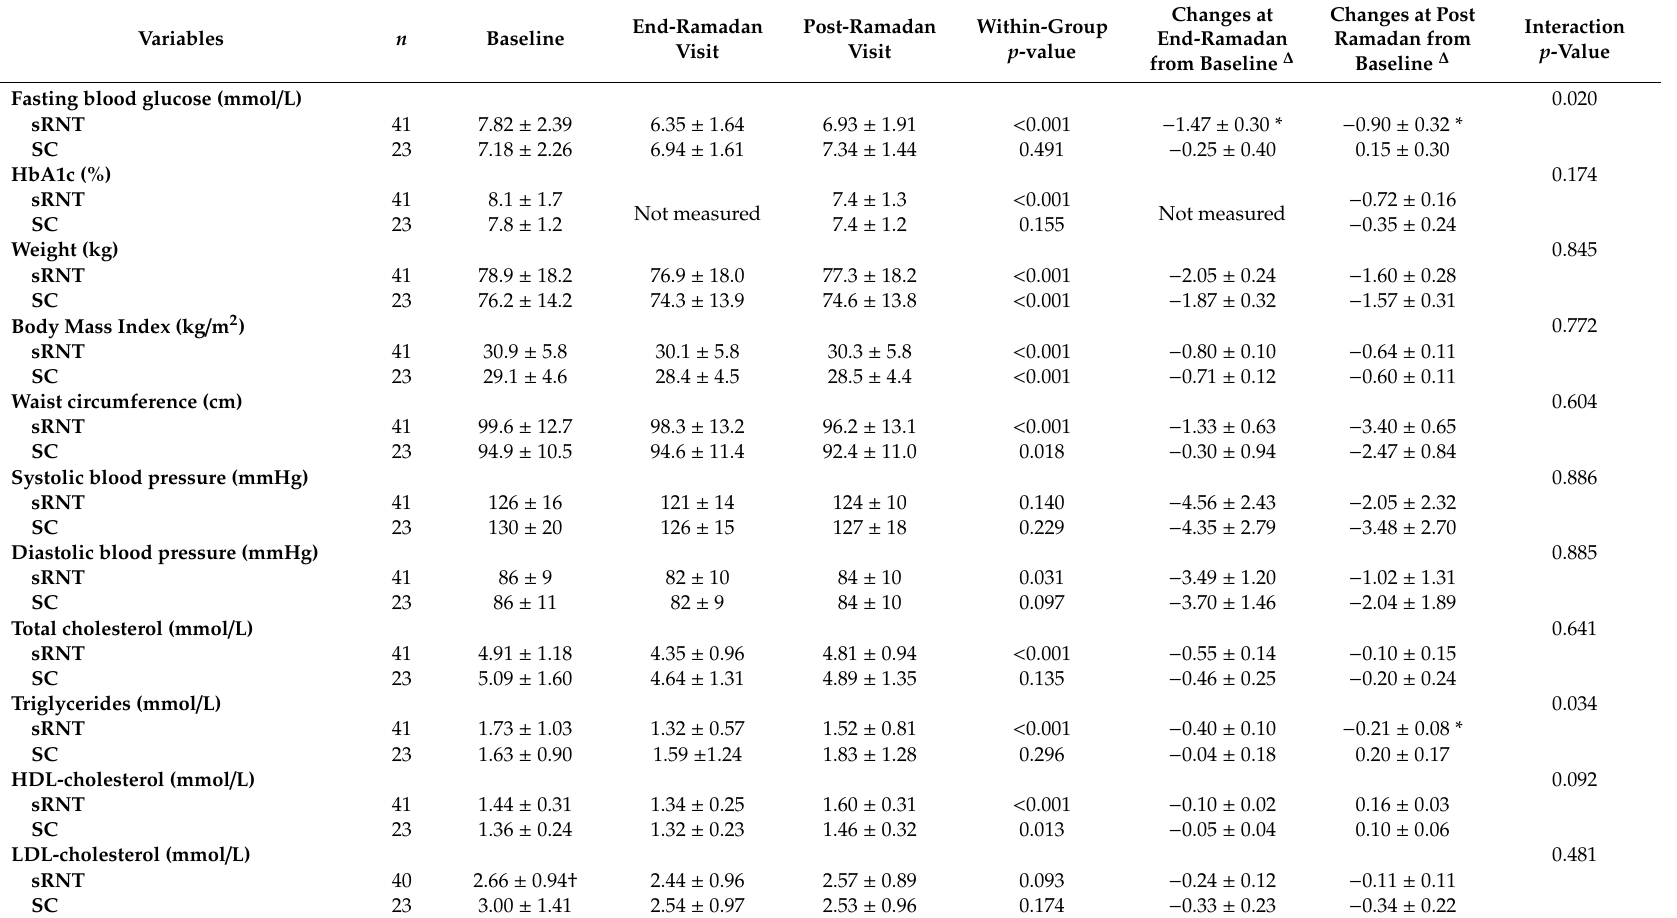
Table 3. Clinical outcomes, dietary intake, and quality of life throughout the study ( n =